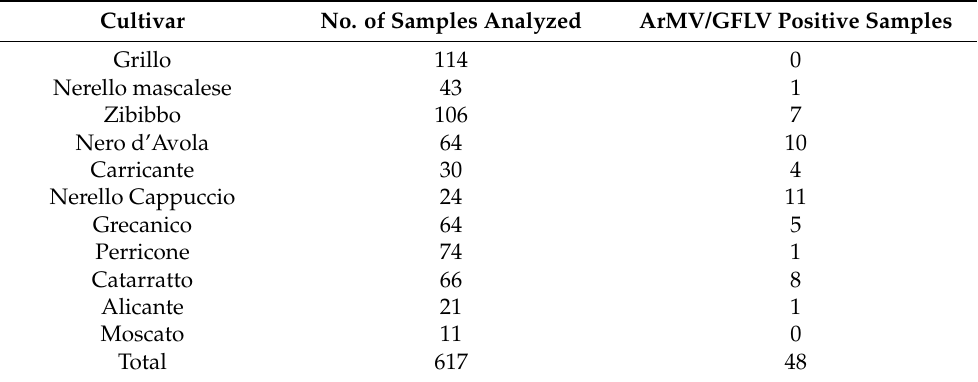
Table 1. Number of samples for each cultivar analyzed by DAS-ELISA and resulted positive for ArMV/GFLV. Cultivar No. of Samples Analyzed Grillo 114